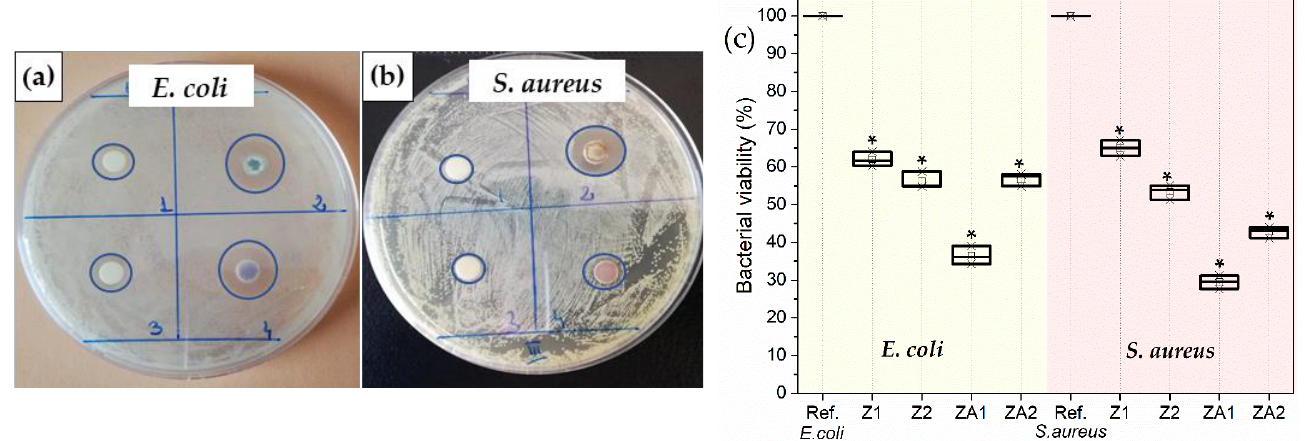
Figure 5. Disc diffusion assay- inhibition zone formed against the growth of ( a ) E. coli and ( b ) S. aureus : 1- Z1, 2- ZA1, 3-Z2, 4-ZA2; ( c ) Bacterial viability by TTC assay for E. coli and S. aureus . The data represent the mean ± SD of three replicates. * denotes the statistical significant difference compared with controls ( p < 0.001). Table 2. The diameters of the inhibition zones for E. coli and S. aureus strains.